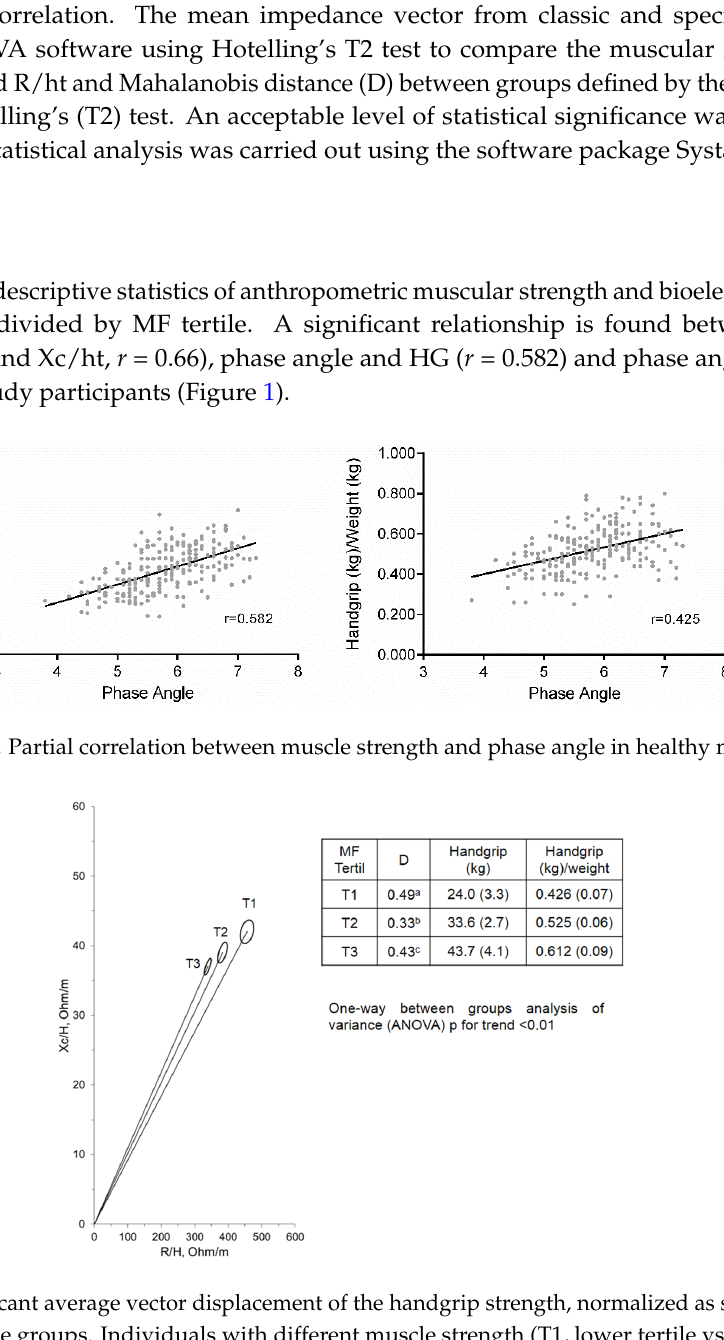
Figure 2. Significant average vector displacement of the handgrip strength, normalized as strength per body mass tertile groups. Individuals with different muscle strength (T1, lower tertile vs. T3, higher tertile) revealed significantly different bioelectrical characteristics. D = Mahalanobis distance between two groups defined by the two correlated variables. a = 1 vs. 2; b = 2 vs. 3; c =1 vs. 3. H, height. T2 = Hotelling’s statistic, 1 vs. 2, T2 = 9.6; 2 vs. 3, T2 = 6.1; 1 vs. 3, T2 = 2.2.